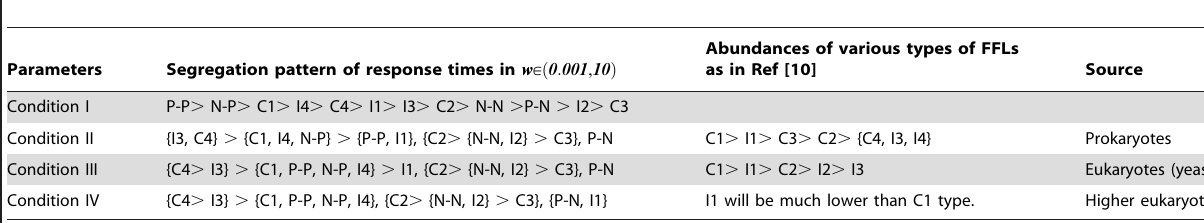
Table 3. Summary of segregation patterns at weak and strong binding